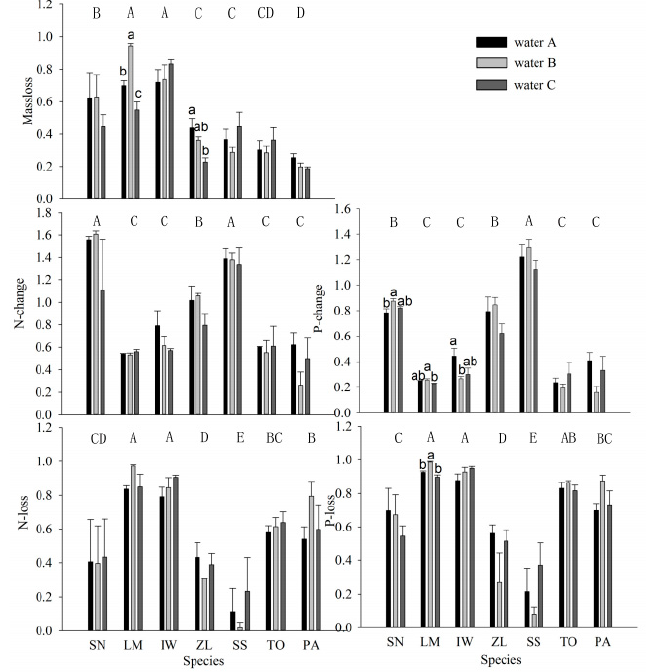
Figure 2. Effects of water substrate (A: polluted water; B: purified water by a constructed wetland; C: natural tap water) and plant species on the litter mass loss, the TN and TP changes, and the TN and TP losses. Error bars show SE. Upper letters (A, B, C, D) show the results of multiple comparisons among plant species; lower letters (a, b, c and no symbol) show the results of multiple comparisons among different water substrates. Species are: SN— Salvinia natans ; LM— Lemna minor ; IW— Iris wilsonii ; ZL— Zizania latifolia ; SS— Sparganium stoloniferum ; TO— Typha orientalis ; PA— Phragmites australis .